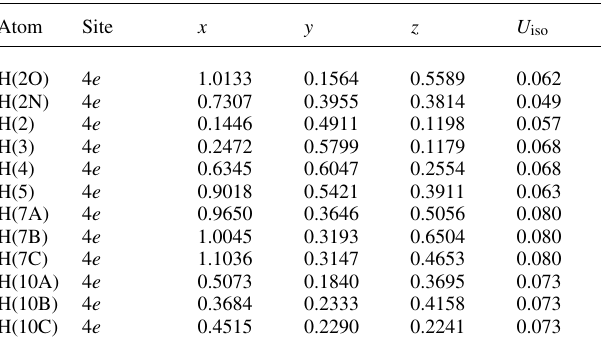
Table 2. Atomic coordinates and displacement parameters (in Å 2 )